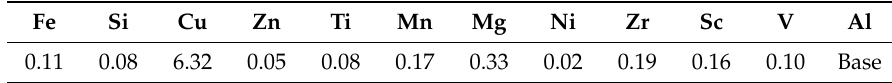
Table 1. Chemical composition of AA2519 (% weight)